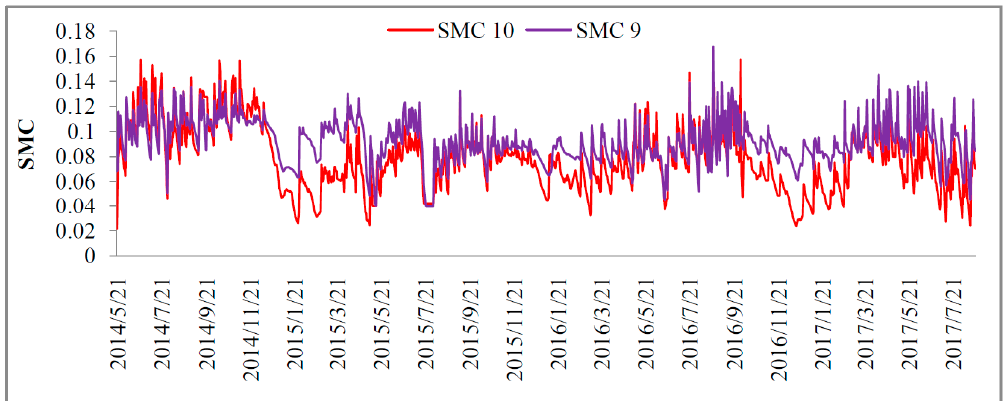
Figure 5. Soil moisture content (SMC) recorded by soil moisture sensors (Decagon EC-5) at the Yindongzi landslide site from 21 May 2014 to 22 August 2017.